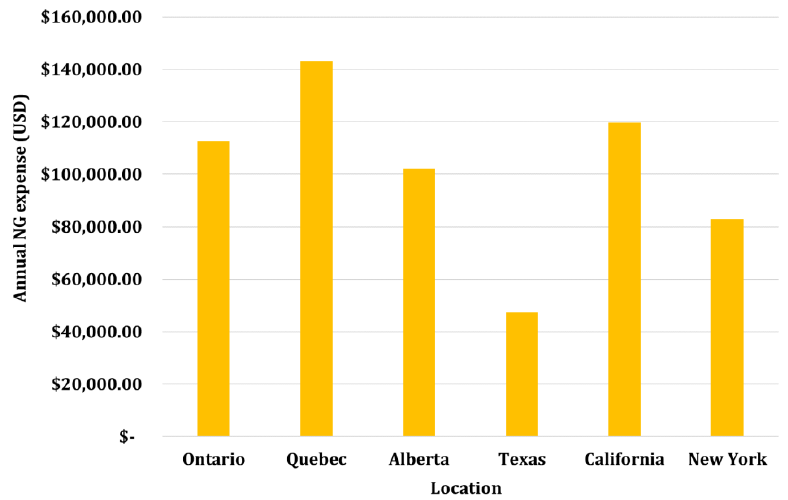
below in Figure 27. below in Figure 27.